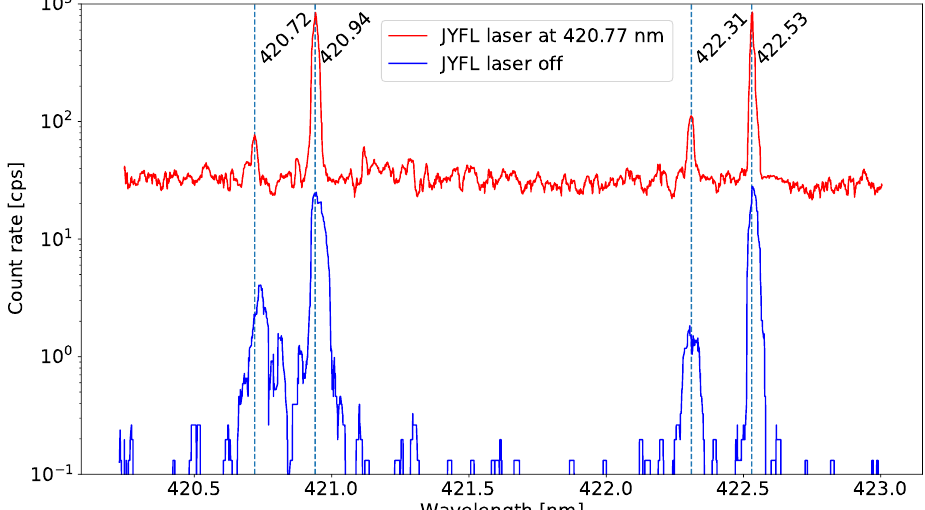
Figure 4. Wavelength scan of plutonium obtained from the grating-based Ti:Sapphire with (red) and without (blue) the 420.77 nm laser light produced by the JYFL broadband frequency-doubled Ti:Sapphire laser. The vertical dotted lines indicate the peak maxima according to the upper spectrum to allow for comparisons with the lower spectrum.